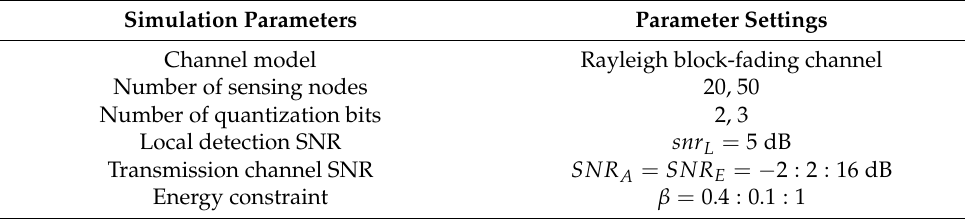
Table 2. Simulation parameter